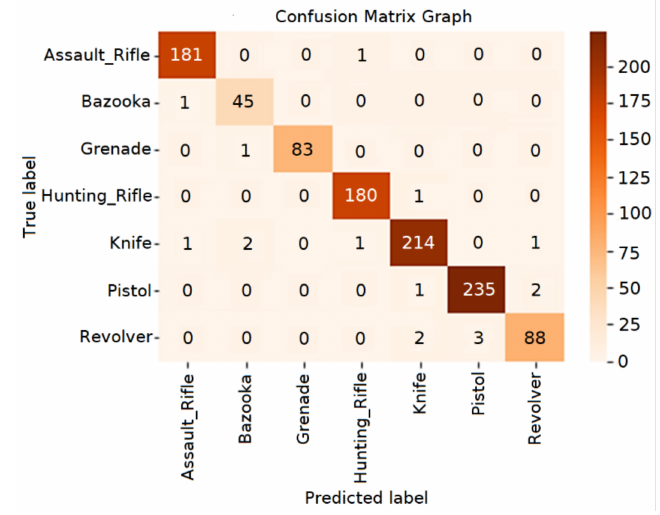
Figure 5. Confusion matrix graph.